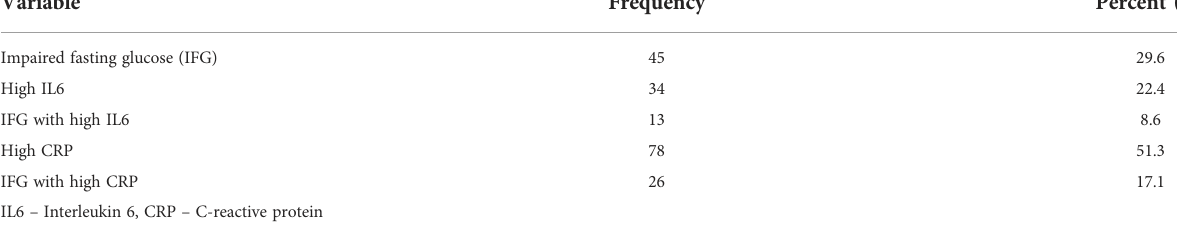
TABLE 2 Proportion of impaired fasting glucose, high IL6, and high CRP (n = 152).